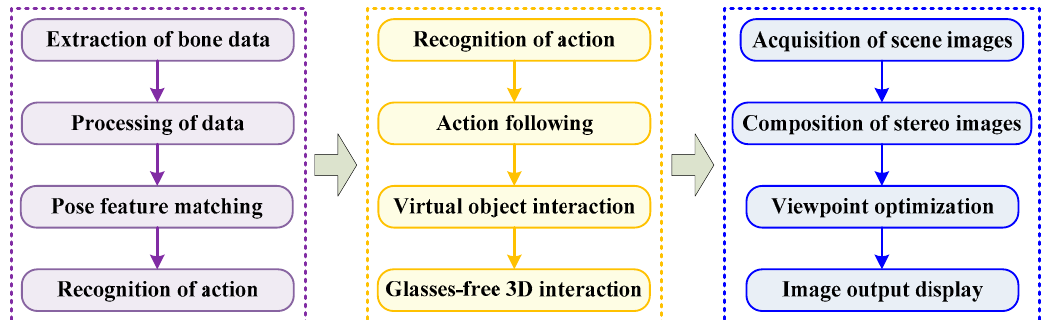
Figure 4. The basic framework of a naked eye 3D interactive system.